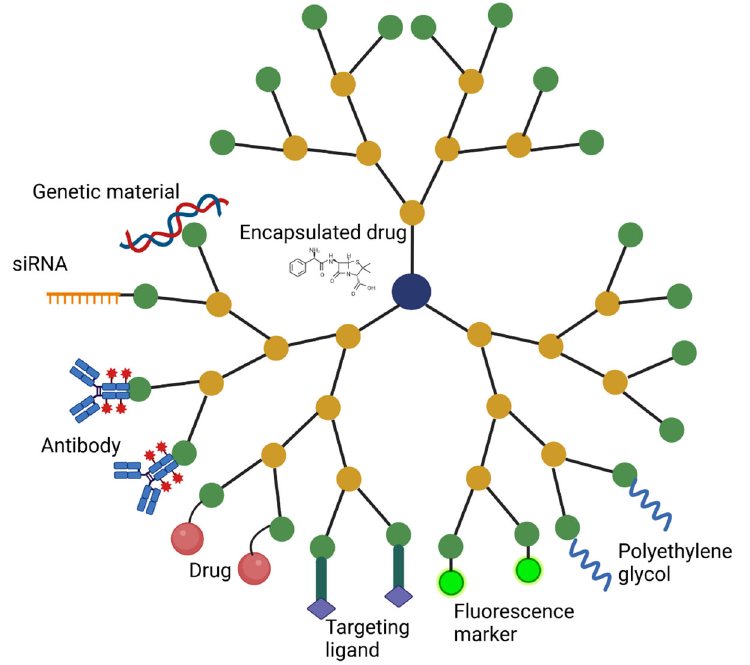
Figure 2. Dendrimer modifications and therapeutic attachments. Drugs can be encapsulated within the inner core or attached to surface functional groups. Dendrimers can carry a range of cargo, including DNA, siRNA, antibodies, and drugs. Addition of polyethylene glycol can improve dendrimer “stealth” and bioavailability. Fluorescence markers can be attached for drug tracking. Ligands can be attached that target specific receptors on the surfaces of cells of interest, improving specificity and minimizing side ‐ effects.